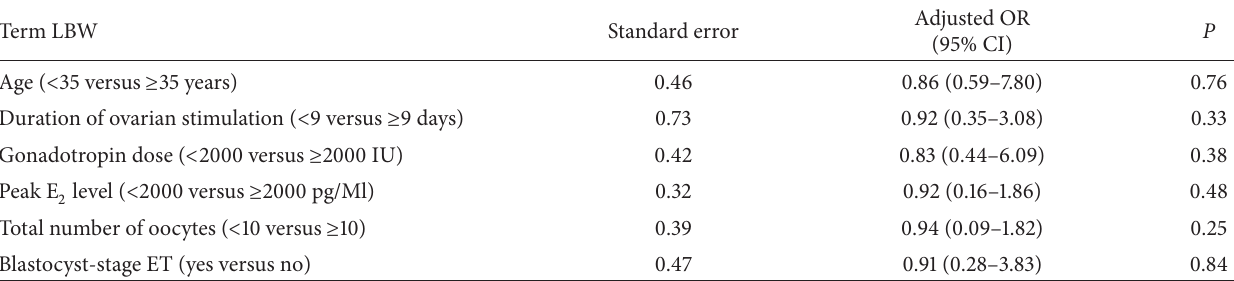
Table 7: Term low birth weight and multiple logistic regression to account for confounding